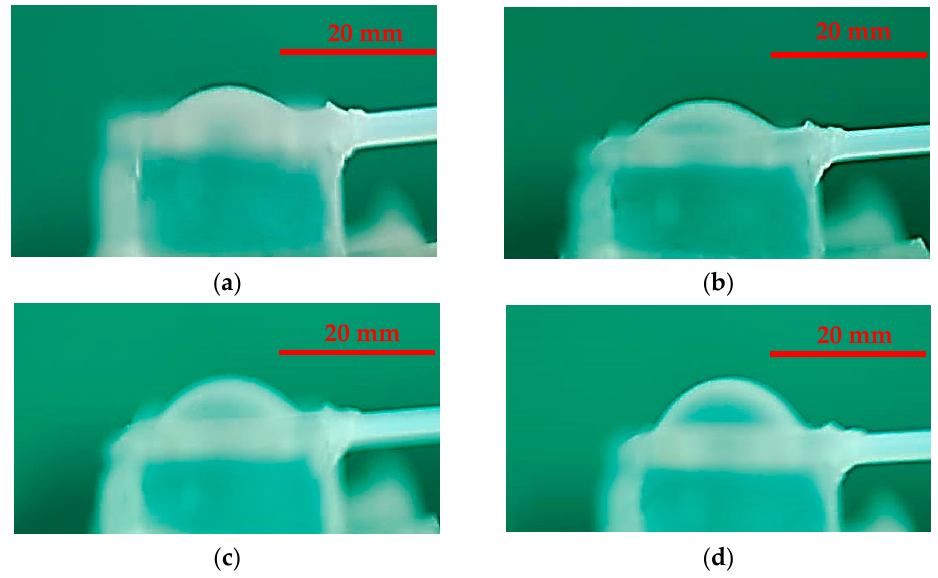
Figure 5. Experimental deformations of the actuated membrane under the pressures of ( a ) 20.68 kPa, ( b ) 34.47 kPa, ( c ) 48.26 kPa, and ( d ) 68.95 kPa.